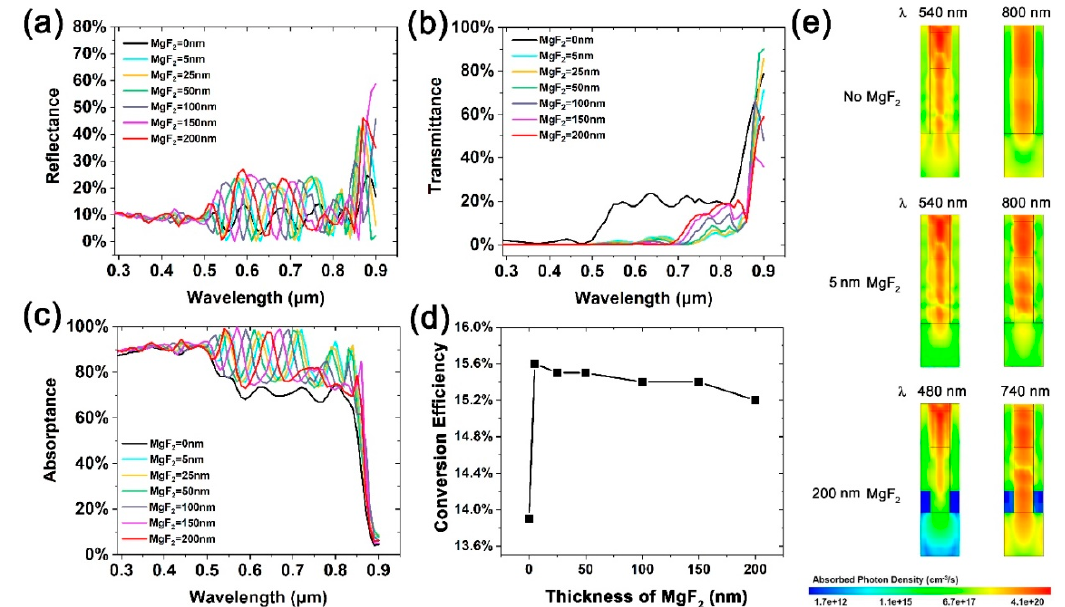
Figure 4. ( a ) Reflectance, ( b ) transmittance, ( c ) absorptance, and ( d ) conversion efficiency of BRE-NWA structures with different MgF 2 thicknesses. ( e ) Vertical cross sections of optical generation profiles at several absorption peaks for 0, 5, and 200 nm thick MgF 2 layers.